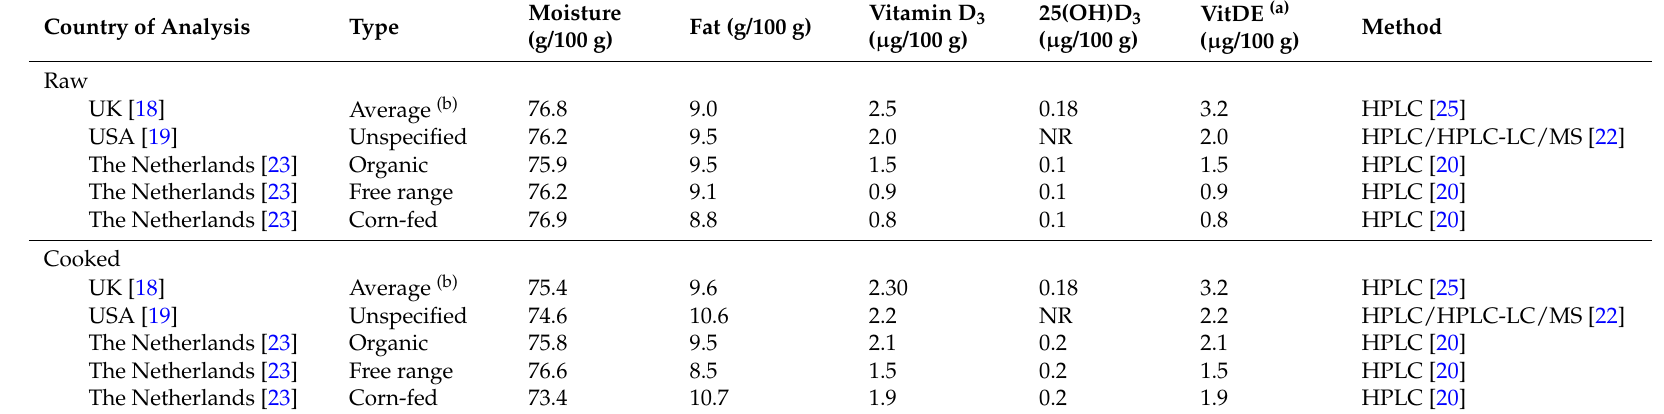
Table 5. Internationally sourced data for moisture, fat, vitamin D 3 , 25-hydroxyvitamin D 3 and vitamin D equivalents in eggs. Country of